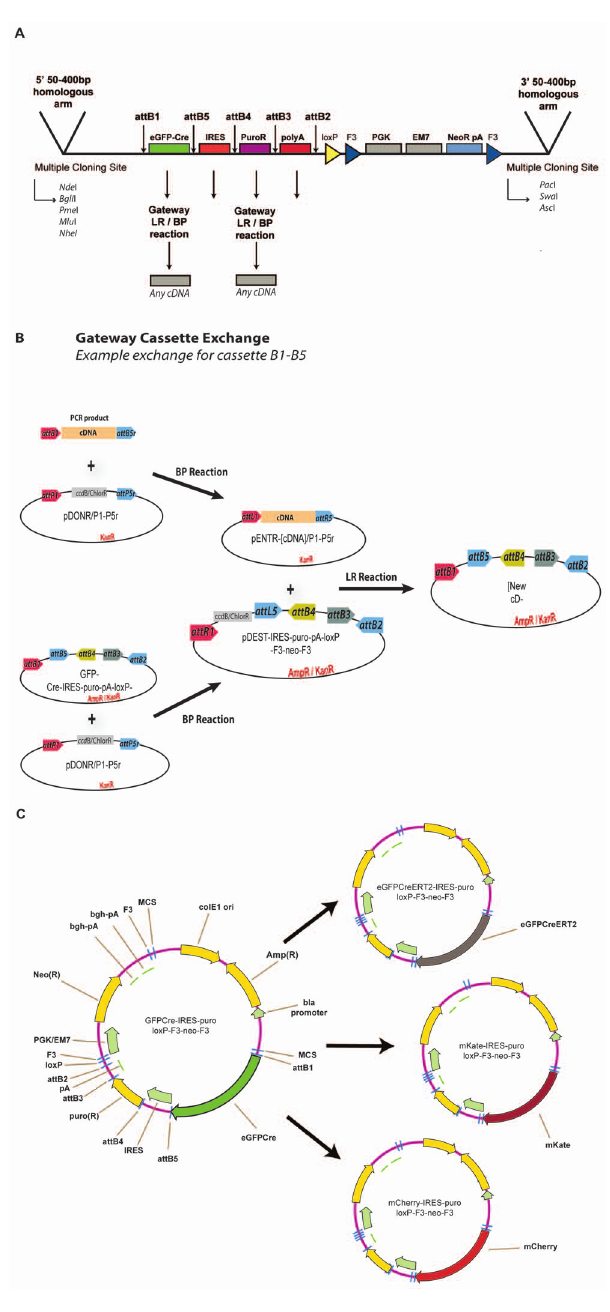
Figure 2. Additional flexibility in pMULTIrec. A. Detailed schematic (not to scale) of att configuration and multiple cloning sites in pMULTIrec. B. Example of Gateway cassette exchange. Any cDNA of interest can be PCR-amplified cloned into the desired pDONR vector to generate a new pENTR clone. The same pDONR vector is used in a BP reaction with pMULTIrec, transformed in ccdB R bacteria and selected using Amp/Cam double selection. This generates a new DEST vector with the ENTR cassette in place of the desired fragment. This new cDNA is transferred to this new DEST vector via a standard LR reaction. C. Additional pMULTIrec variants we have